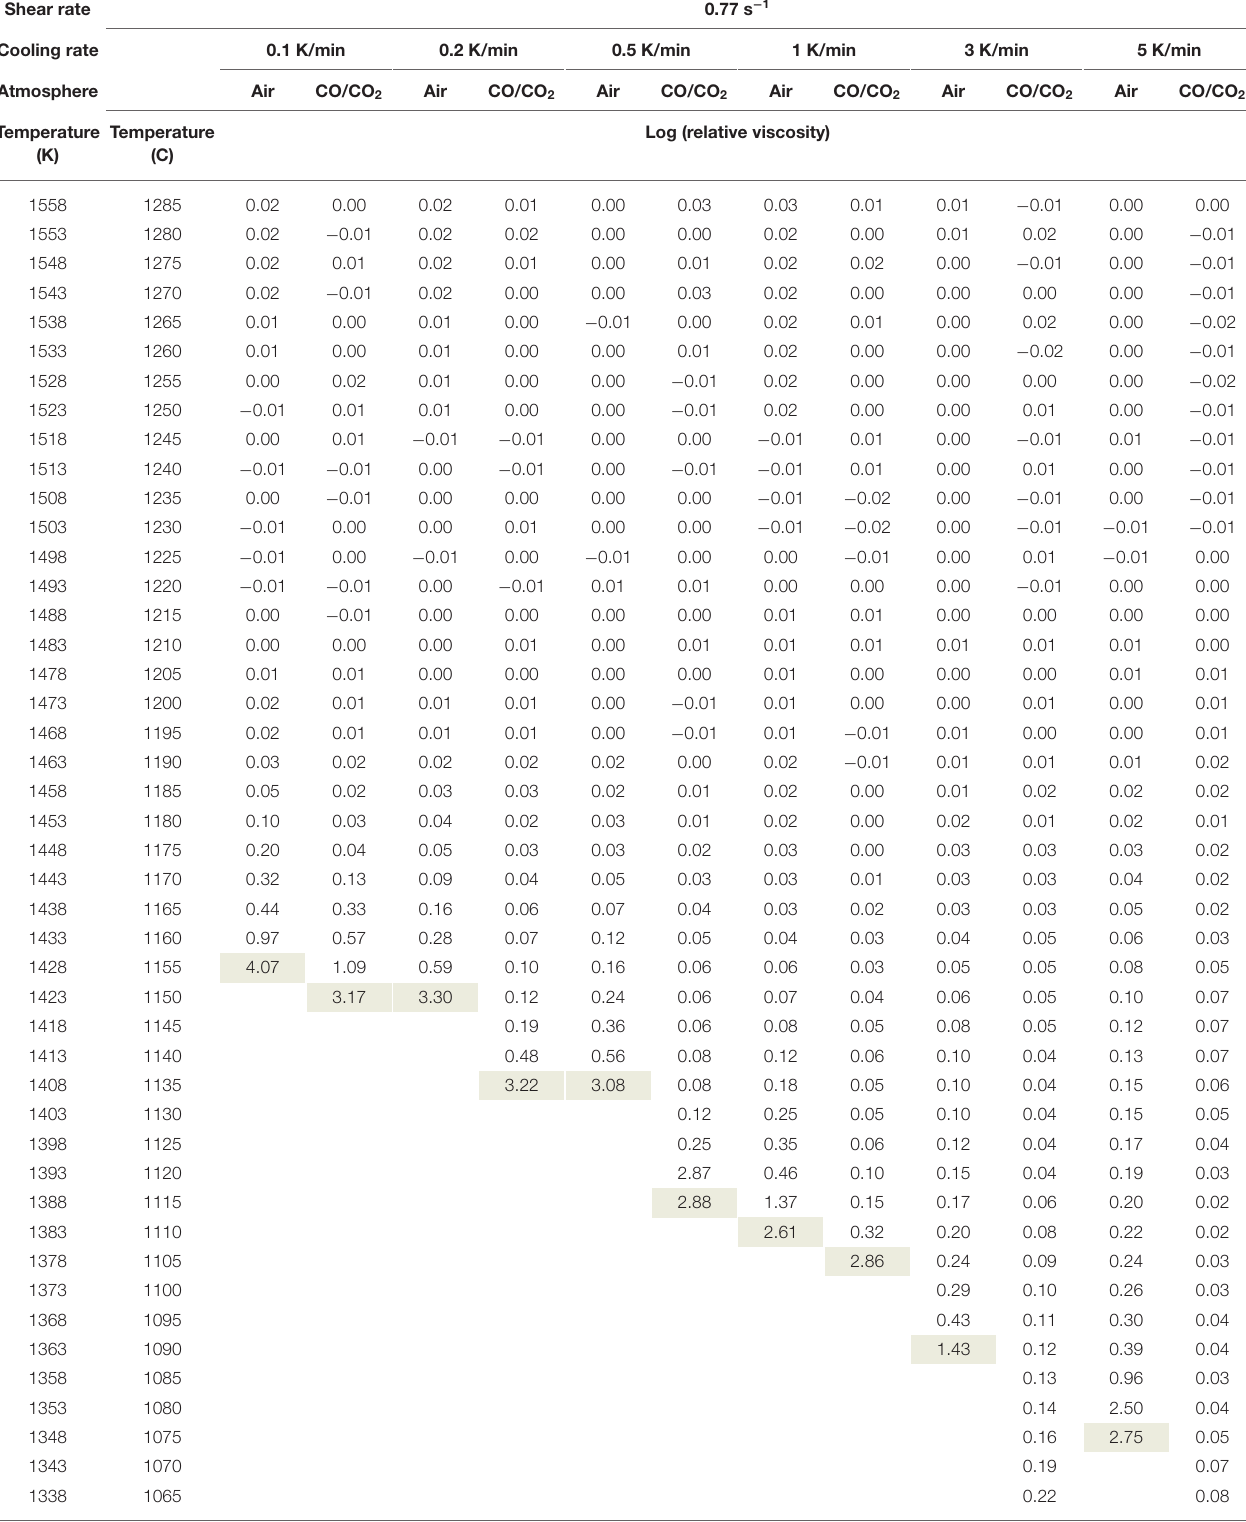
TABLE 4 | Summary of the calculated relative viscosities of all experiments. Shear rate Cooling